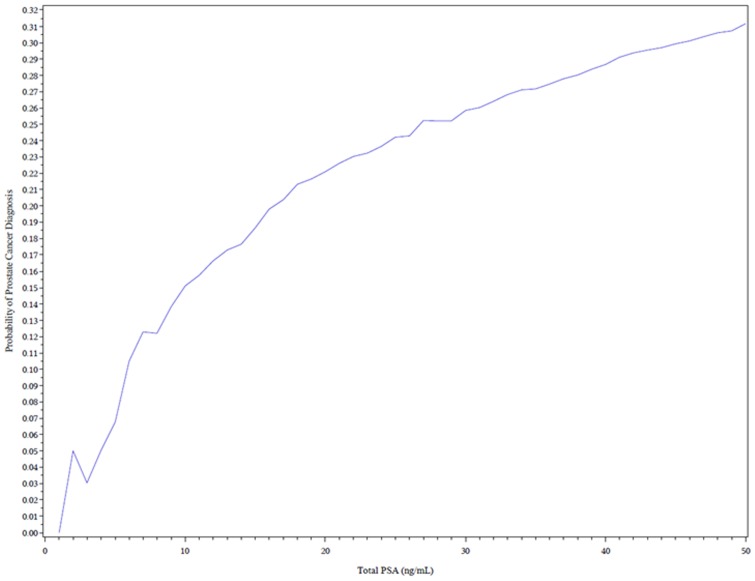
Probability of having prostate cancer with increasing PSA in biopsy population.The probability of having prostate cancer when undertaking prostate biopsy is raised from nearly 0% with tPSA<1.0 ng/mL to nearly 31% with tPSA = 50 ng/mL according to our study population. This figure can be use to predict the probability with tPSA level in the future.